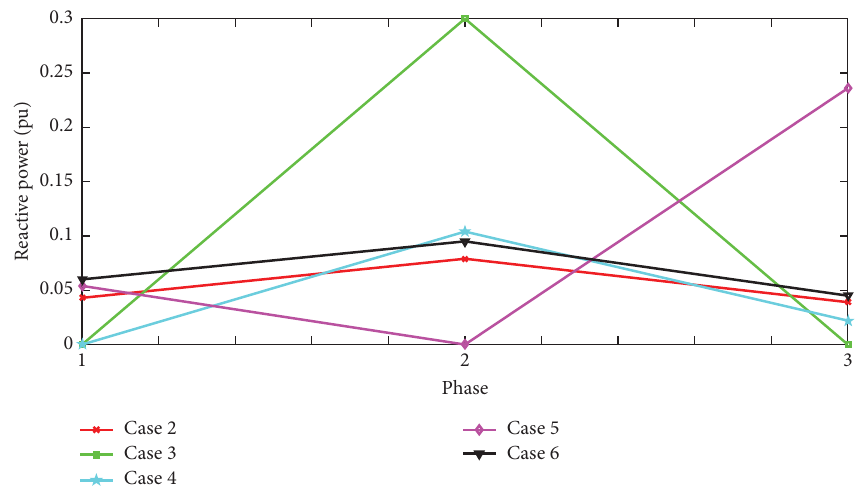
Figure 7: Reactive power generation of each phase of the wind system in diferent case studies.